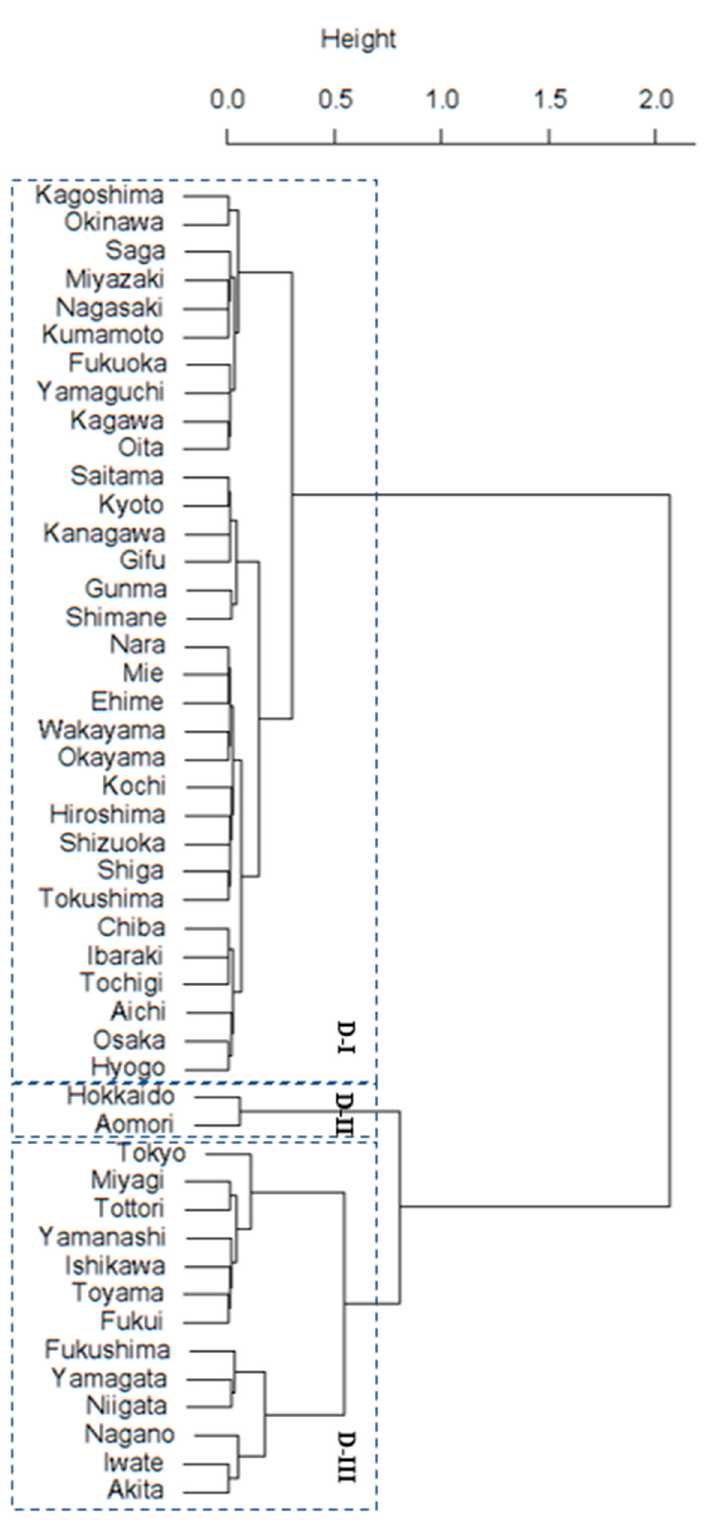
Figure 6. A dendrogram for the drive systems. See Figure A1c for the mapping of the cluster analysis results.